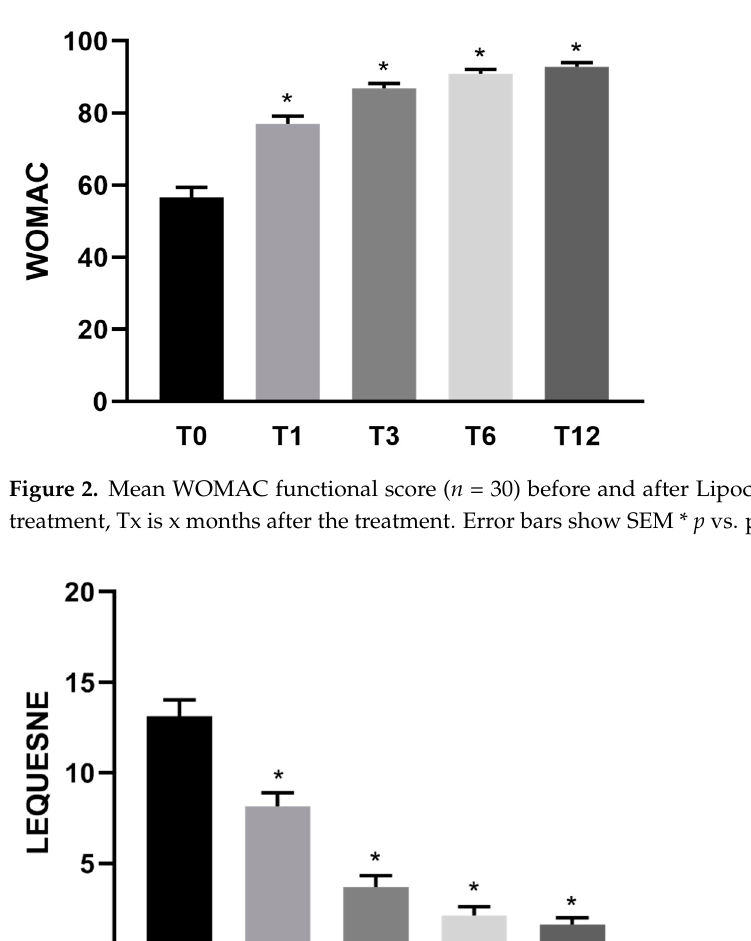
Figure 1. Mean VAS score ( n = 30) before and after Lipocell treatment. T0 is pre-treatment, Tx is x months after the treatment. Error bars show SEM * p vs. pre-treatment <0.01.